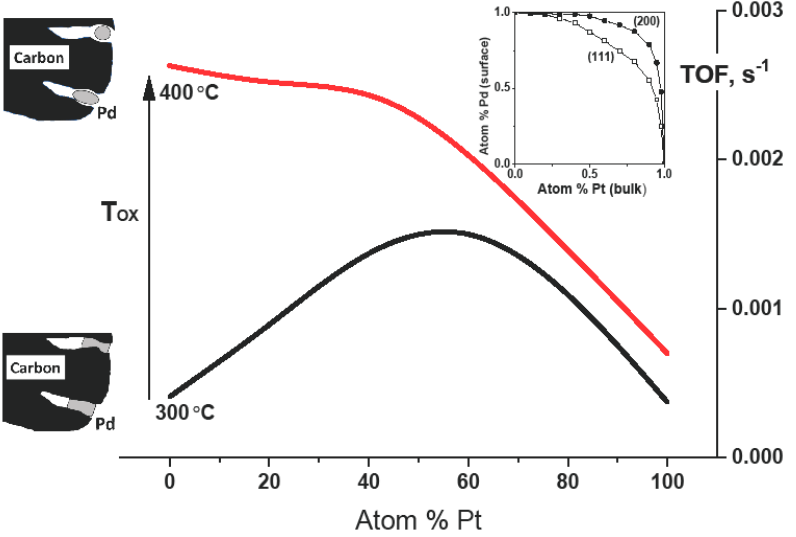
Figure 7. Changes in the catalytic behavior of Pd-Pt/Norit1600 catalysts in chlorodifluoromethane hydrodechlorination caused by catalyst precalcination. Inset: the relation between surface and bulk composition of Pd-Pt alloys adapted from Rousset et al. [28].